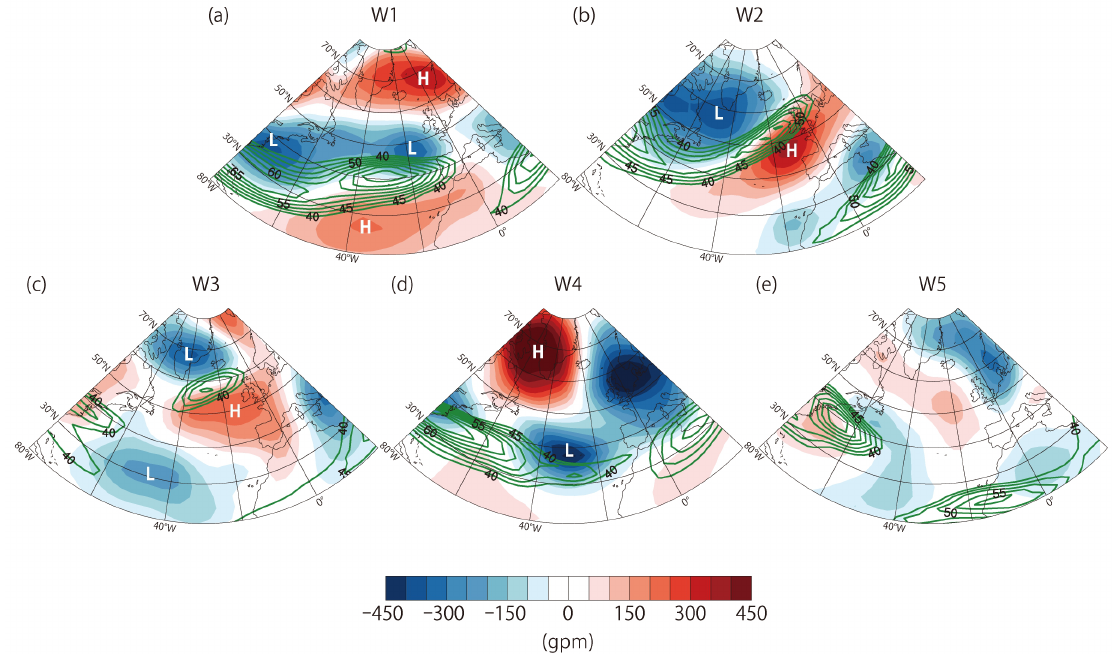
Figure 1. Daily mean geopotential height anomaly (red–blue contours) and zonal wind above 40 ms − 1 (green contours with interval 5 ms − 1 ) at 250 hPa for representative days in winter: ( a ) type W1 on 12 January, 2010; ( b ) type W2 on 1 January, 2015; ( c ) type W3 on 9 January, 2012; ( d ) type W4 on 20 December, 2009; and ( e ) type W5 on 19 February, 2012. “H” and “L” represent the high and low geopotential height